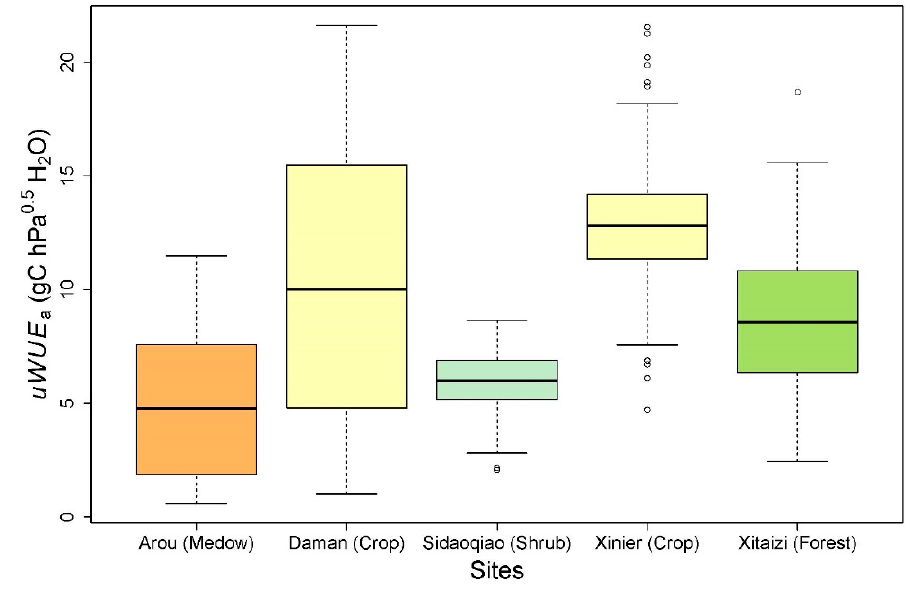
Figure 7. Frequency distribution of weekly uWUE a.